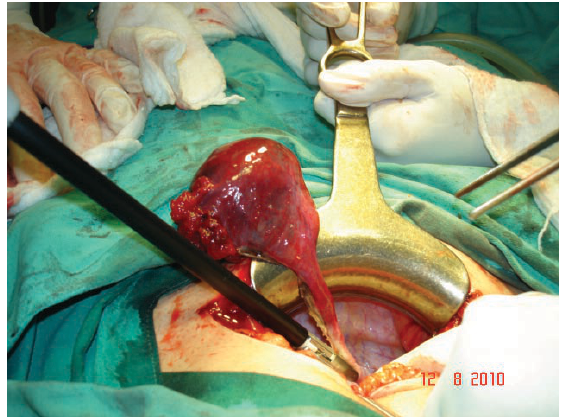
Figure 2. Left salpingectomy performed using